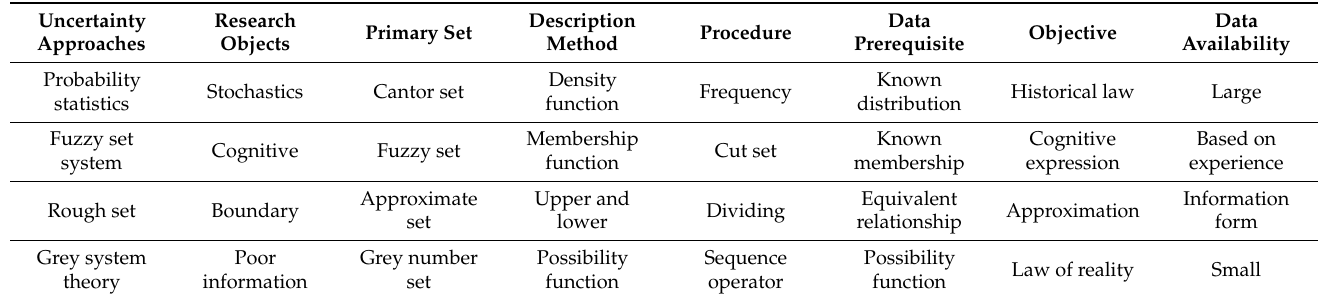
Table 2. Comparative overview of the approaches for modeling uncertainty